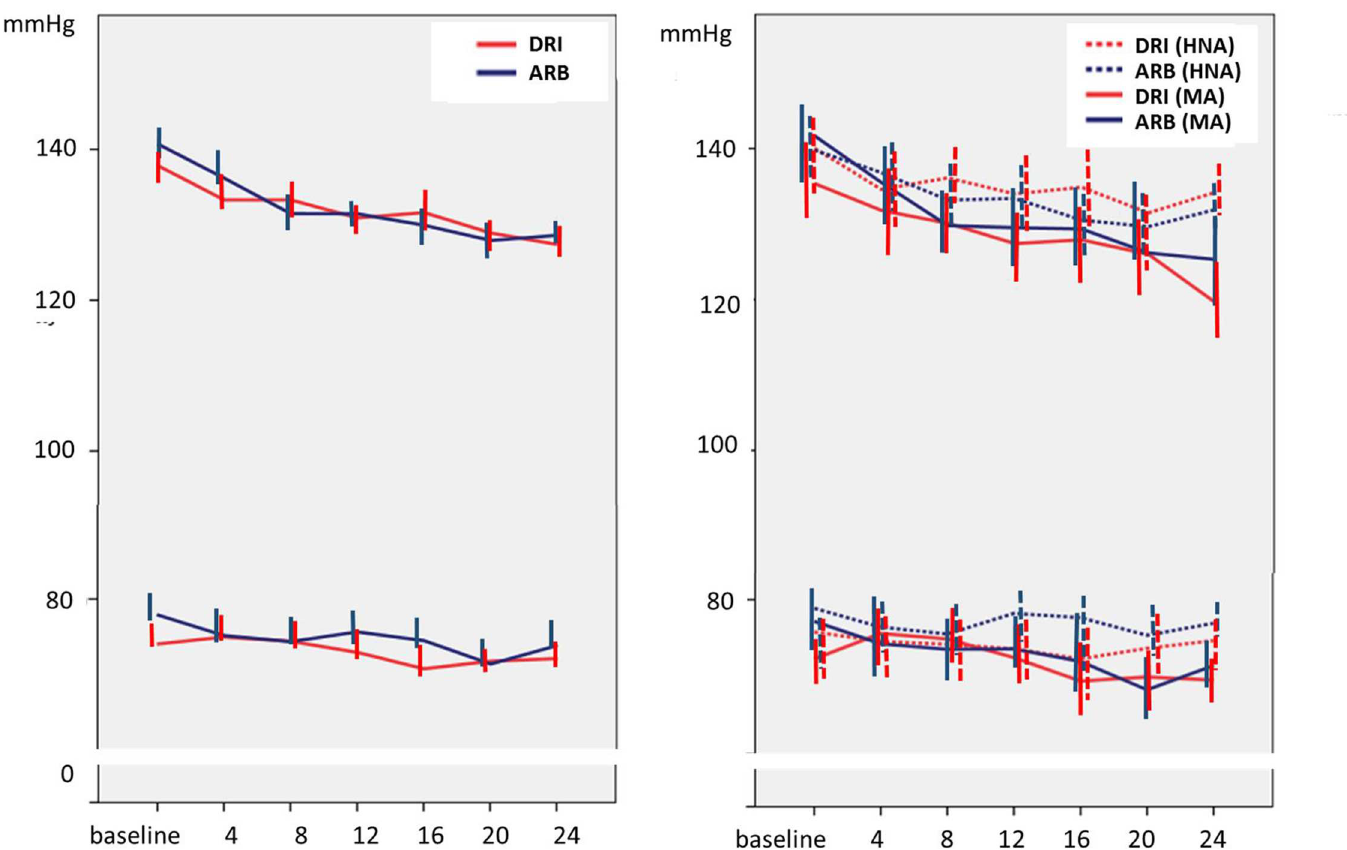
Fig 2. The mean changes in the systolic blood pressure and diastolicblood pressure during follow-upfor the two treatment arms (A) and for the subgroups (B). DRI; direct renin inhibitor, ARB; angiotensin receptor blocker, HNA; high normal albuminuria, MA; microalbuminuria. Error bars represent 95% confidential intervals.